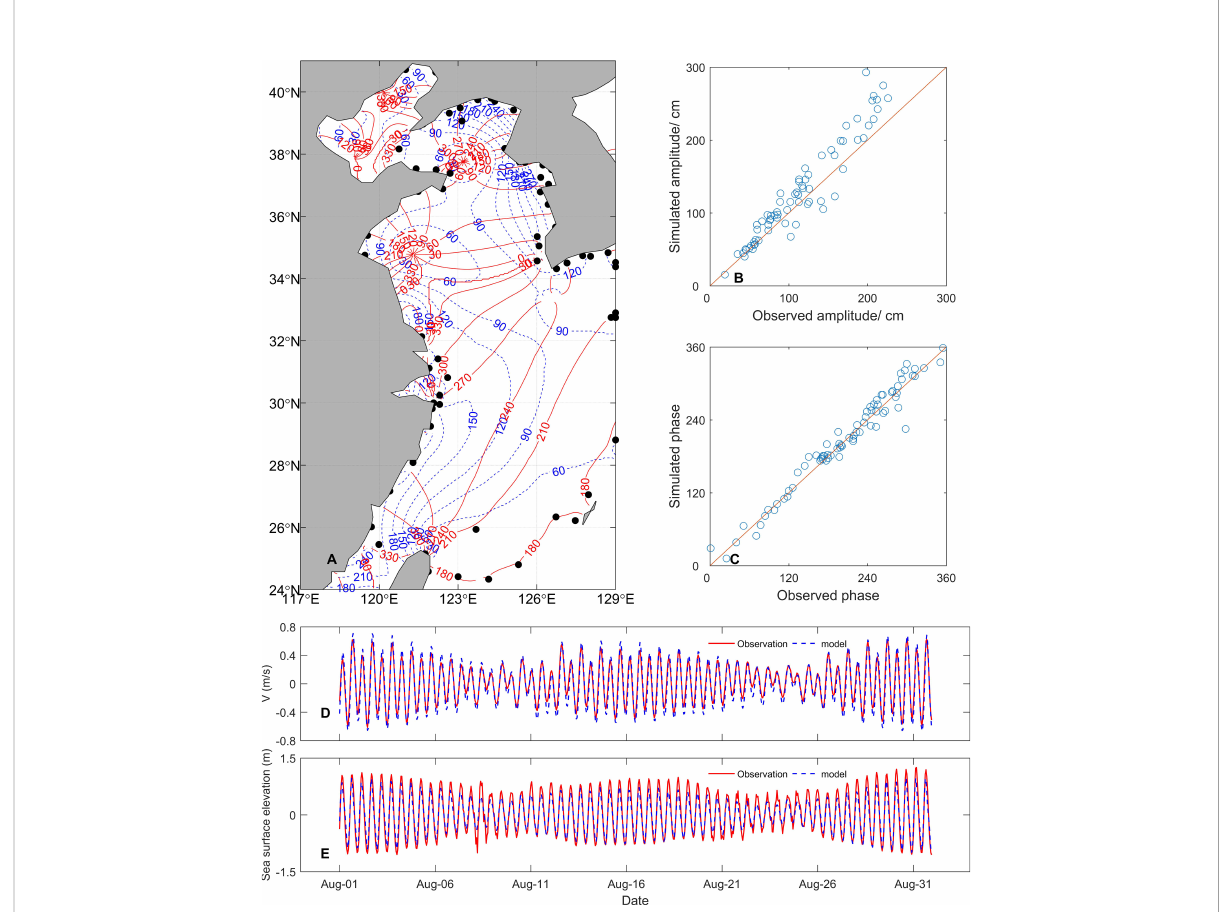
FIGURE 4 Modelled cotidal charts (A) of M 2 . The blue dashed lines and red solid lines denote the amplitude (cm) and phase lags (degrees), respectively. The black dots denote locations of 75 tide gauges (A) . Comparison between the modelled and observed amplitudes (B) and phase lags (C) at 75 tidal gauges. Comparison between the modelled and observed depth-mean meridional velocity (D) and sea surface elevation (E) at the mooring site. The blue and red lines in the (D) and (E) represent model results and observations,